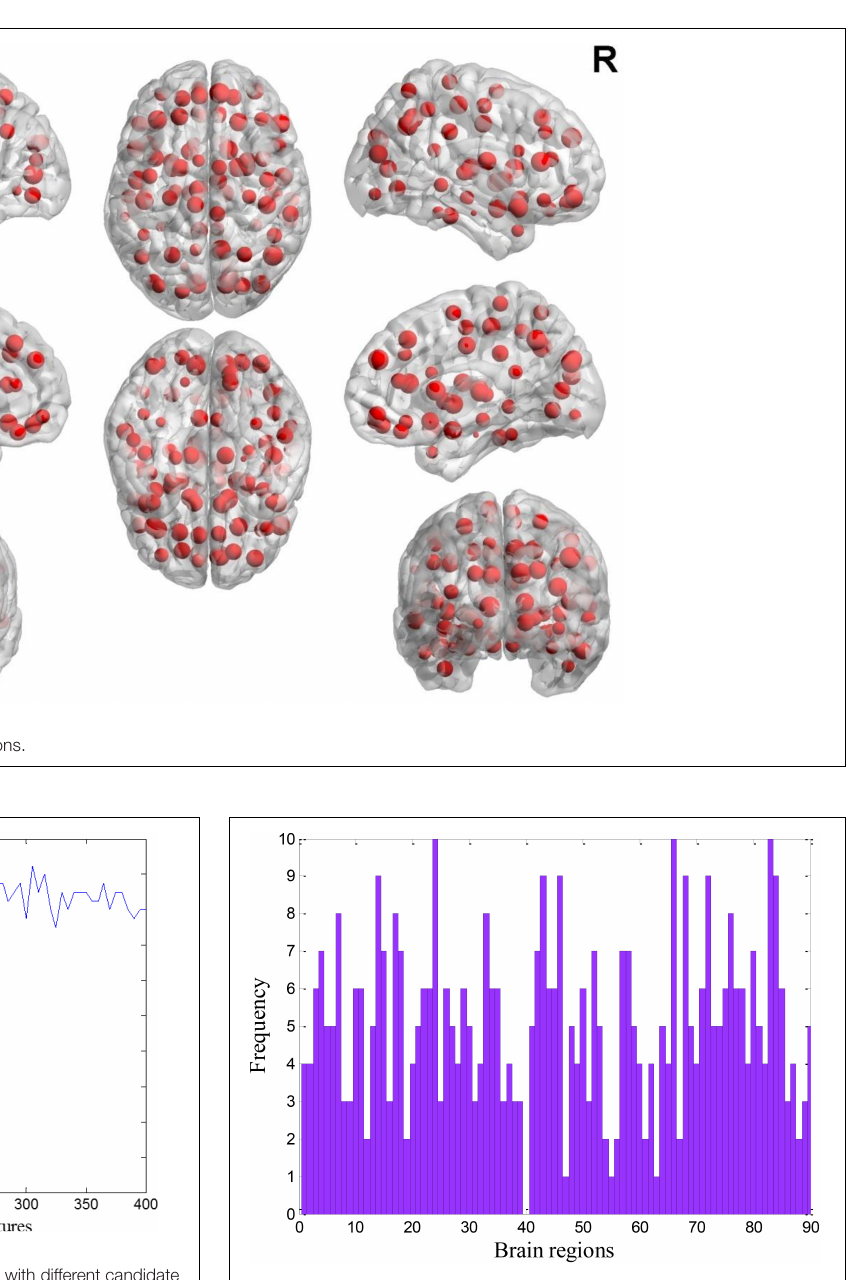
FIGURE 7 | The frequency of the brain